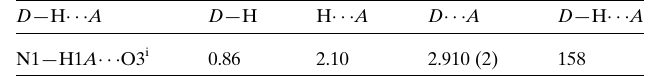
Table 1 Hydrogen-bond geometry (A˚ , (cid:2) ).